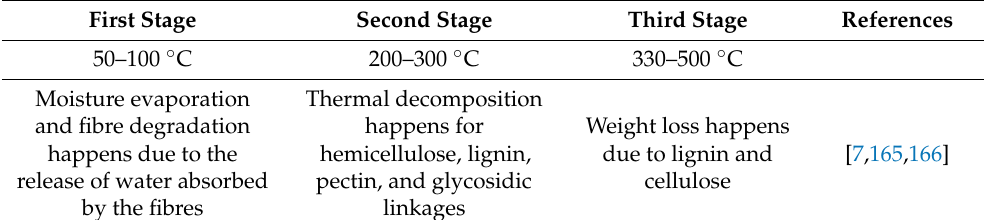
Figure 12. ( a ) TG and ( b ) DTG curves of fique fibres [161] (reprinted with permission from Elsevier,